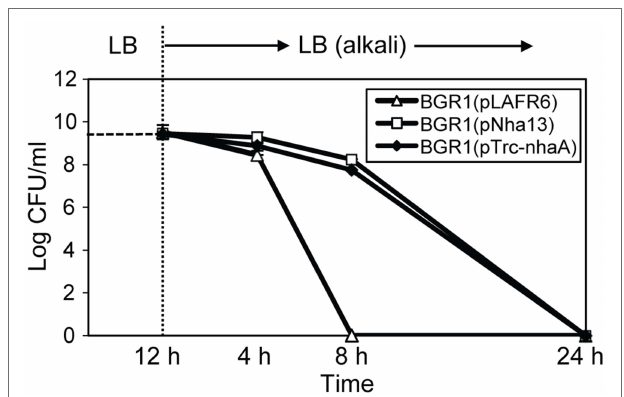
FIGURE 9 | Cell viability of wild-type BGR1 carrying pLAFR6, pNha13, or pTrc-nhaA after exposure to alkaline stress at pH 9. pNha13 and pTrc-nhaA indicate pLAFR6 containing the nhaA gene derived from E. coli with its native promoter or the nhaA gene with the trc promoter, respectively. The cell population was determined based on the number of CFUs using plate- counting methods. Data are mean ± SE of triplicate